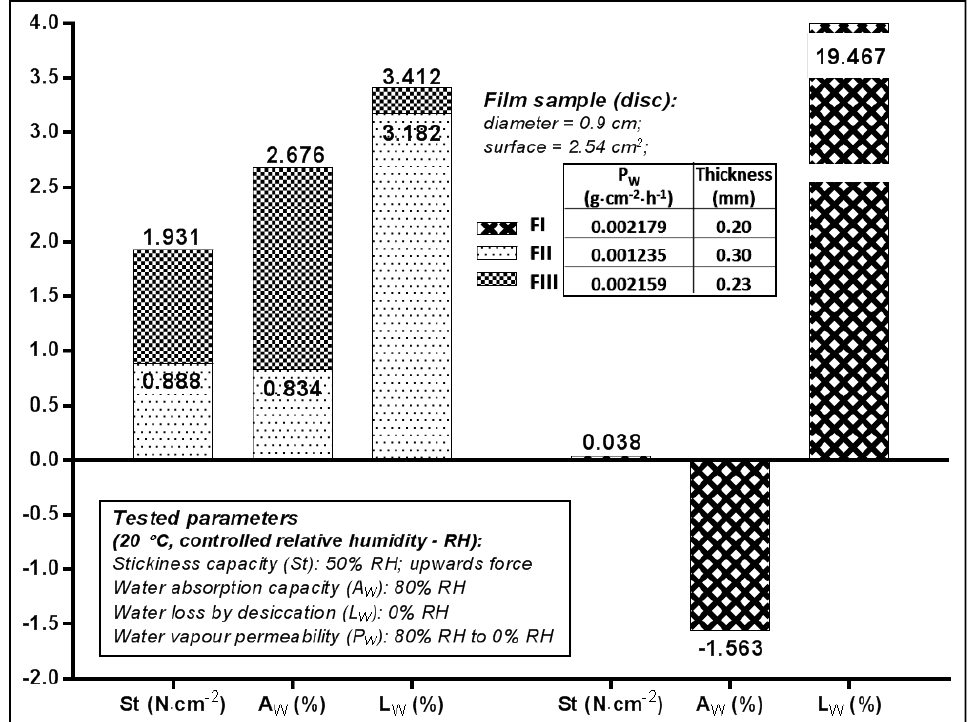
Figure 2. Properties of the film samples used for the in vitro Franz test.